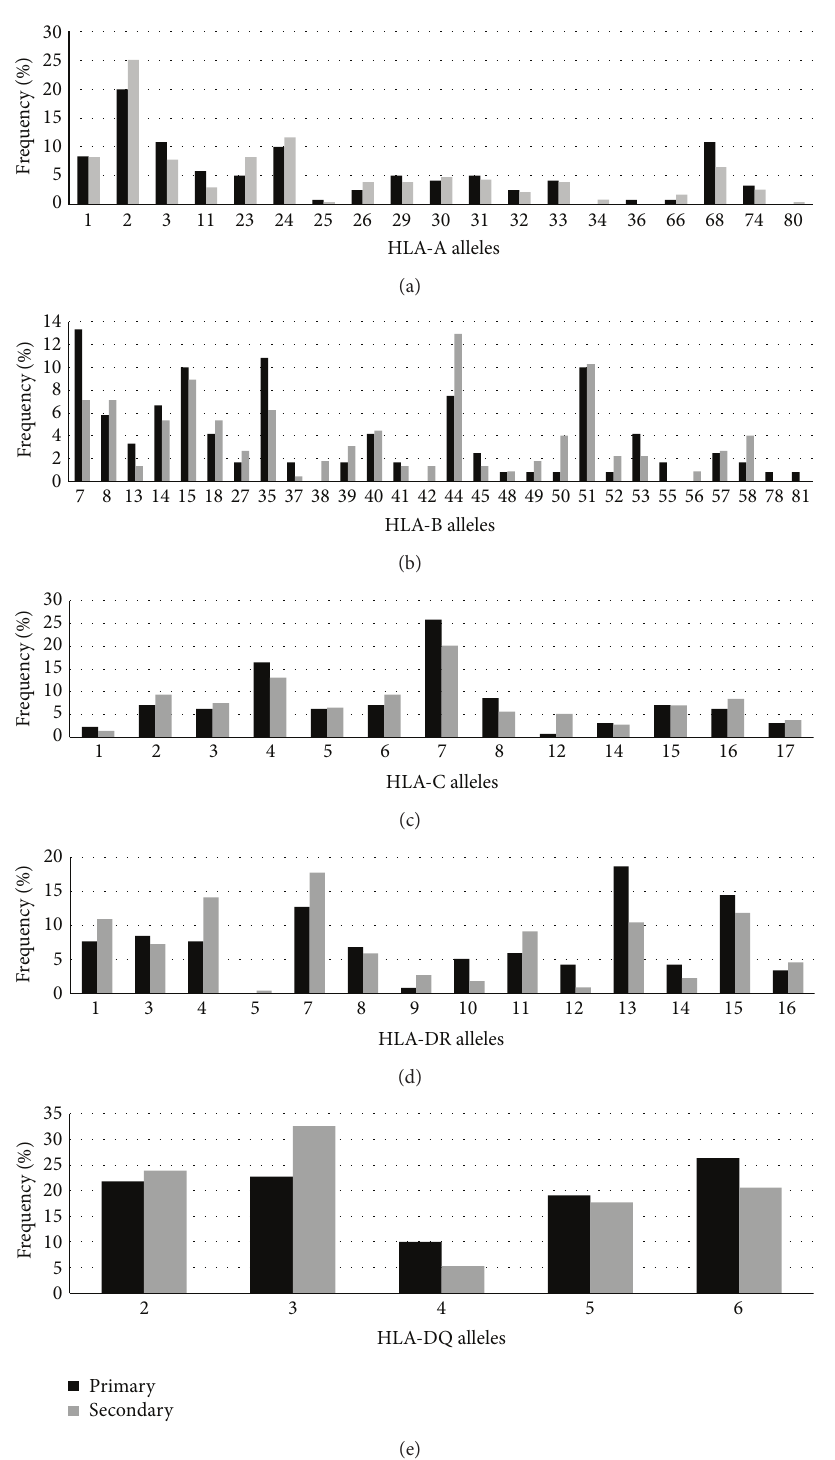
Figure 2: Allele versus primary-secondary frequency for HLA in the study population. (a) HLA-A, (b) HLA-B, (c) HLA-C, (d) HLA-DR, and (e)